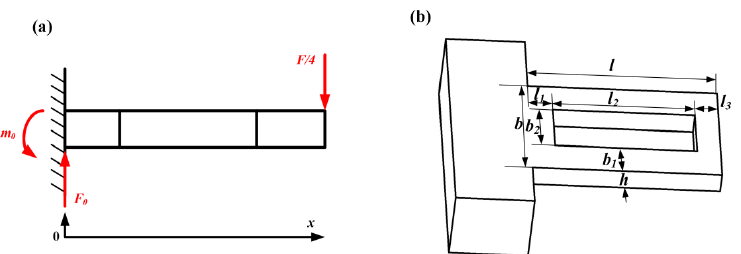
Figure 3. The force analysis and dimensions for SQB structure.